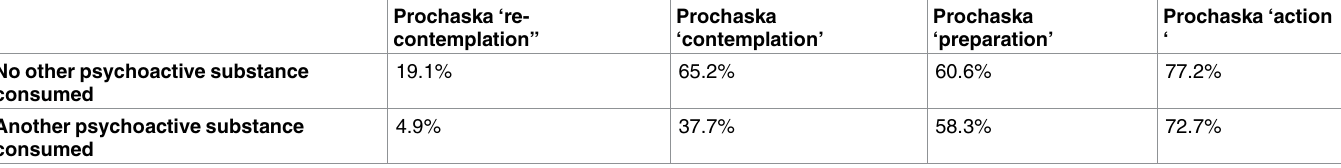
Table 5. Frequency of abstinence according to consumption of another psychoactive substance and the level in the Prochaskaalgorithm at the initial